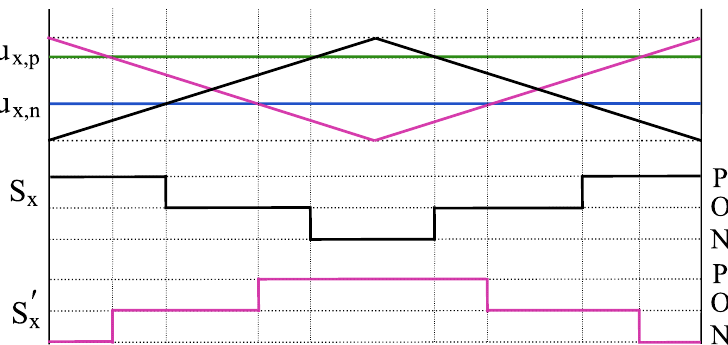
Figure 6. Reversed switching patterns using two carriers with opposite